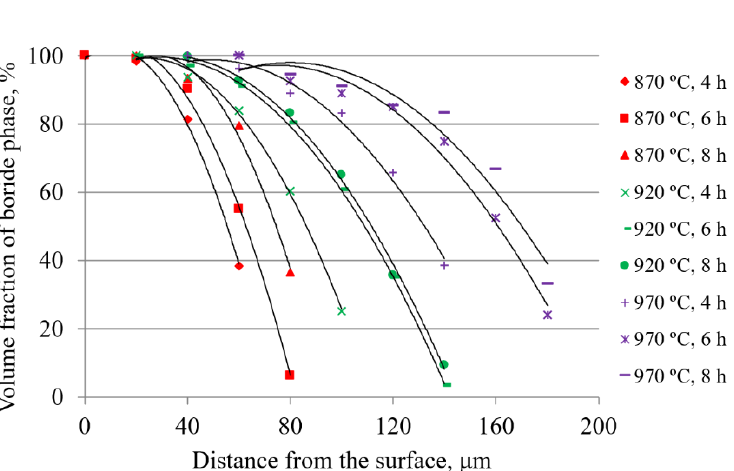
Figure 5. Cross-sectional change in the volume fraction of the boride phase on C70W2 steel.